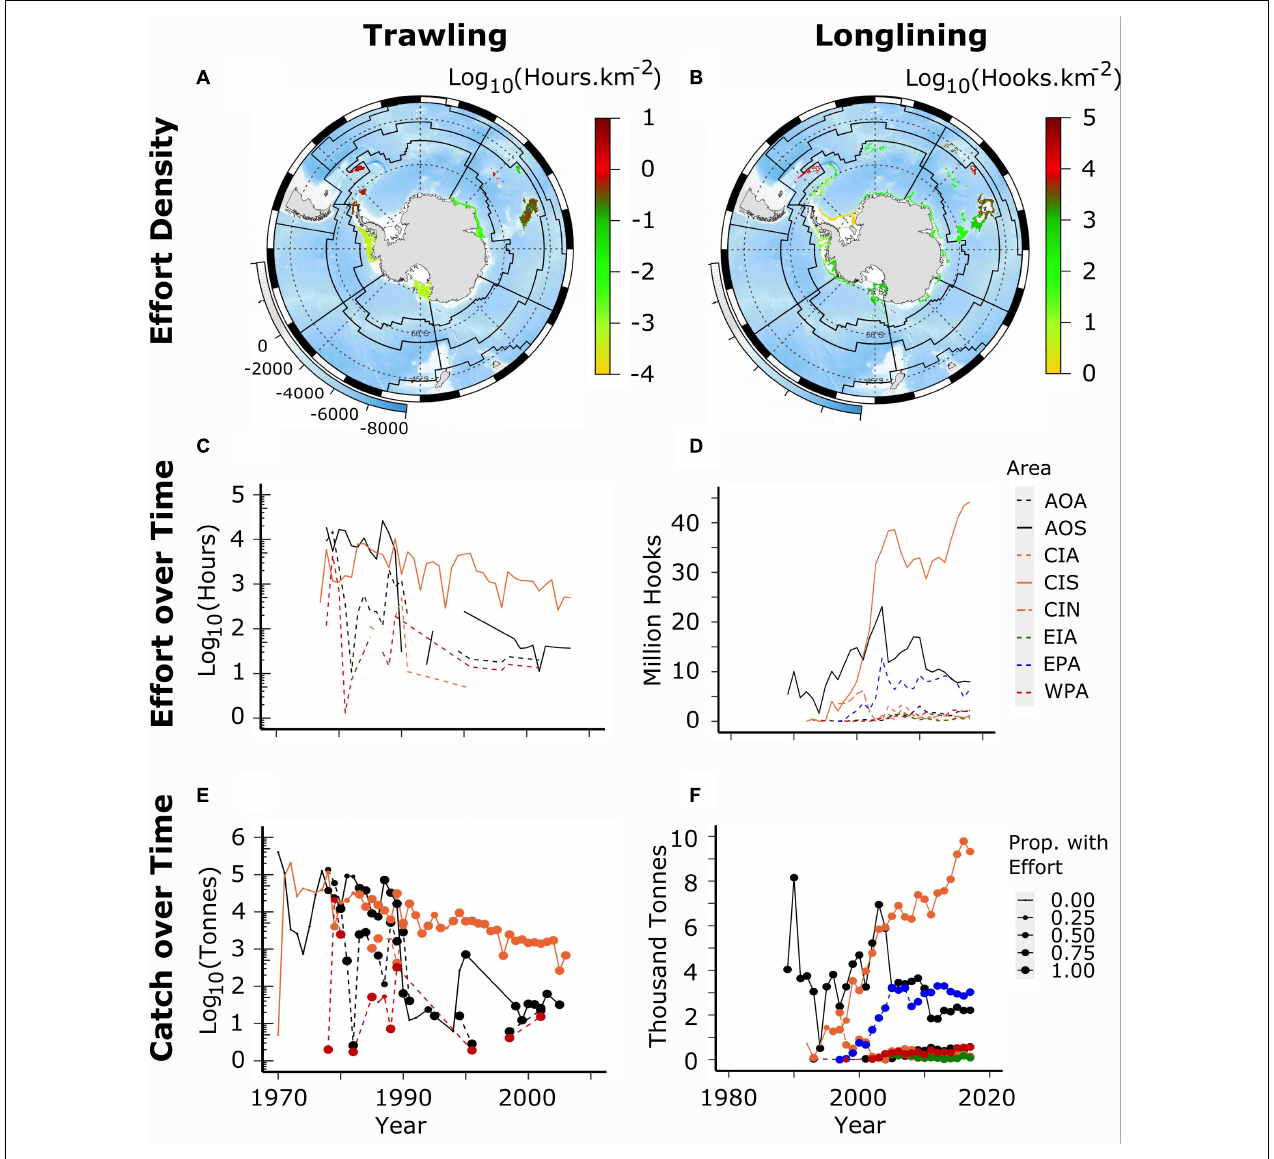
FIGURE 7 | Bottom fishing effort in MEASO areas for trawl and longline fisheries. (A,B) shows effort density per km 2 – hours and hooks respectively on a log 10 scale. Background is ocean depth (bottom left legend on each map). Black lines show boundaries of MEASO areas as depicted in Figures 3 and 4 . (C,D) shows effort over time (split year) in each MEASO area according to the legend at right. The first two letters correspond to the sector and the last letter to the zone. (E,F) shows the time series of catches in each area – color and line types according to the middle row. Catches are the total catch of targeted species in bottom fisheries (groundfish, icefish, and toothfish). The size of the points indicate the proportion of the catch that had effort data associated with it. Note the effort and catch data are plotted on different scales for each of trawling and long lining and the size of the symbol for each year indicates the proportion of catch for which we have an estimate of effort. When there is no symbol in a year then there is no record of effort. Data derived from the CCAMLR Statistical Bulletin 2019 (see Grant et al., in review, to be published in this research